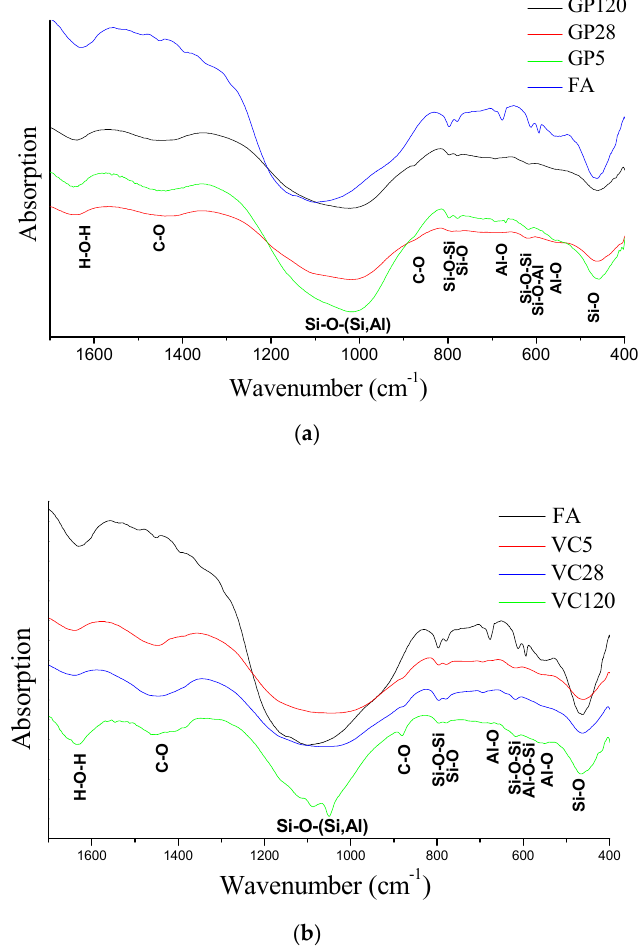
Figure 1. FTIR spectra of ( a ) FA and GP samples, and ( b ) FA and VC samples.